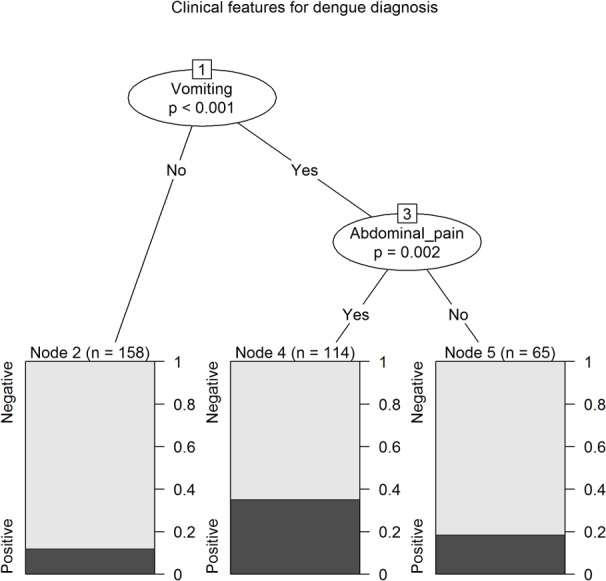
Conditional inference tree for the prediction of reference diagnosis of DENV infection using clinical diagnostics with an association (p<0.05) with reference diagnosis of DENV infection (nausea and vomiting and abdominal pain).